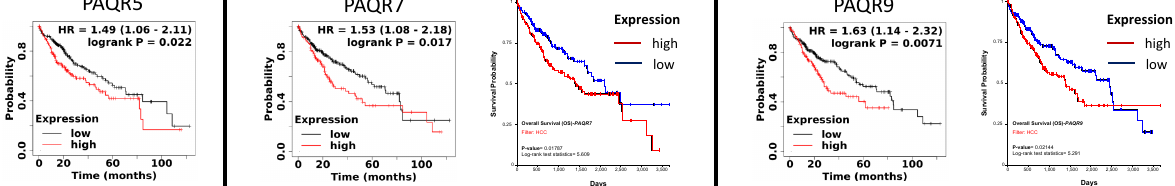
Figure 6. Oncogrid with copy number variations (CNV) and prognostic effects for key CmPn players utilizing microarray data for HCC patients. Utilizing the Genomic Data Commons (GDC) data portal from the National Cancer Institute (NCI), we assessed all available clinical and CNV data for patients diagnosed with hepatic cancers with differential expression for any of the key CmPn players. Additionally, publicly available microarray data from HCC patients were analyzed using either KMplotter or Xena browser (TCGA database) to integrate gene expression and clinical data simultaneously to generate Kaplan–Meier (KM) survival curves. ( A ) CNV analysis for HCC patients with CmPn mutations. The clinical data legend is provided beneath the Oncogrid, as well as coloring scheme for mutation outcomes and CNV impacts. ( B-1 ) Prognostic effects for CCM3 in both KMplotter (left panel) and TCGA databases (right panel). ( B-2 ) Prognostic effects for PGRMC1/2 in